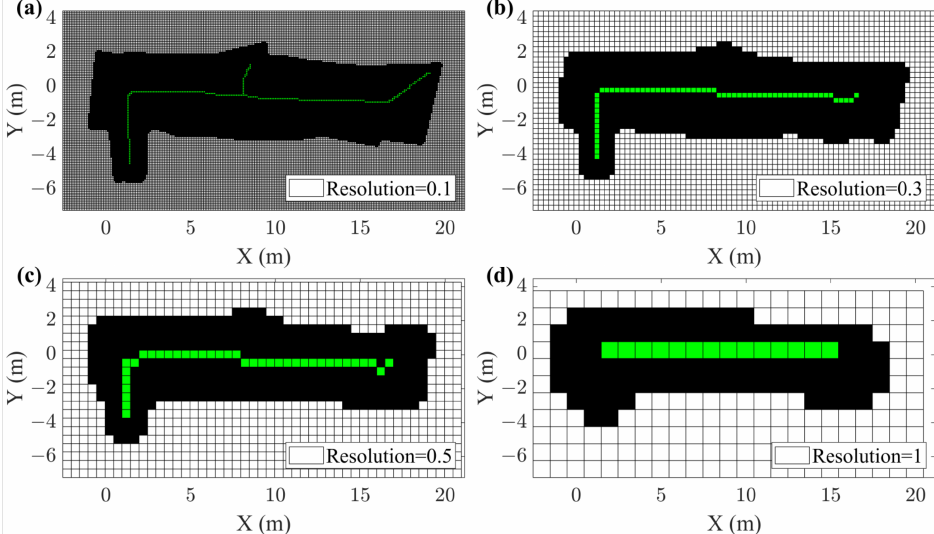
Figure 21. The binary map and its skeleton of the LiDAR data corresponding to Figure 4 under different map resolutions. The map resolution corresponding to ( a – d ) is 0.1, 0.3, 0.5, 1,